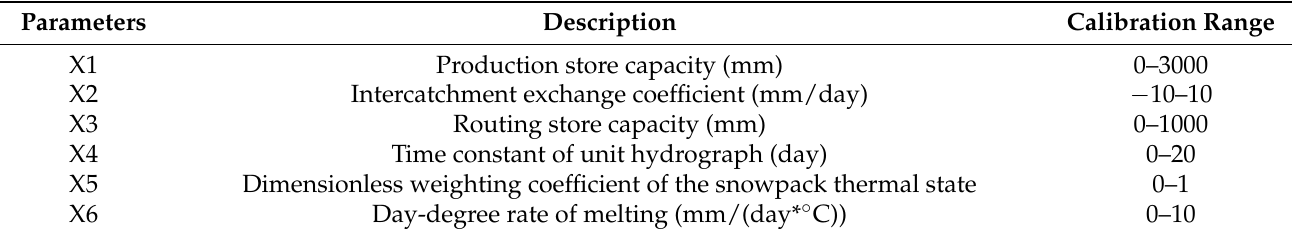
Table 1. Description and calibration ranges for GR4J model parameters (based on Ayzel et al. [21]).